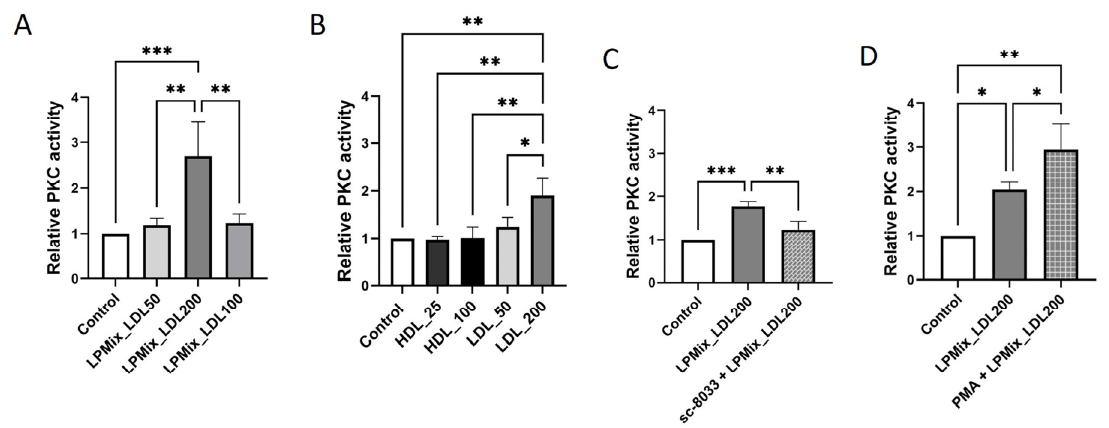
Figure 5. LDL increases PKC activity in endothelial cells. ( A , B ) PKC activity was determined using PKC activity assay kit on total lysates of EA.hy926 cells incubated with LPMix supplemented with LDL in different concentrations ( A ) or with high or low concentrations of purified HDL or LDL ( B ) for 24 h. Expression values relative to control. n = 3, one-way ANOVA. ( C , D ) Relative PKC activity in total lysates of EA.hy926 cells incubated with the LPMix supplemented with high LDL concentrations in the presence/absence of sc-3088 (1 µM) ( C ) or PMA (80 nM) ( D ) for 24 h, as quantified by ELISA. Expression values relative to control. n = 3, two-way ANOVA. All graphs shown as mean ± SD, * p < 0.05, ** p < 0.01, *** p < 0.001.